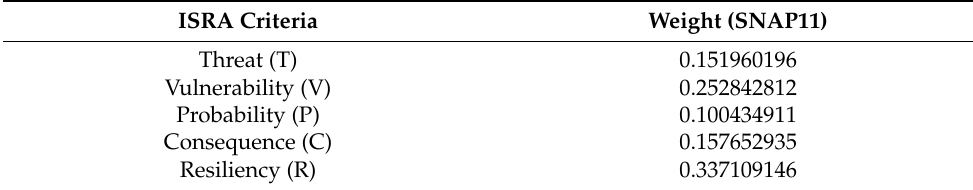
Table 3. Weights of generic ISRA criteria obtained by SNAP11